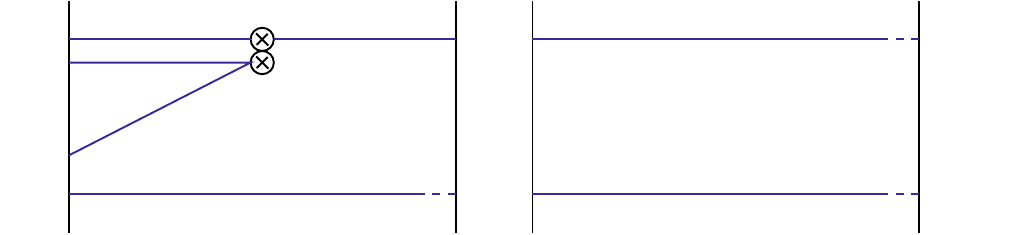
the four-quark operator insertion, and dashed lines indicate the explicit time-like link variable involved in boundary-to-boundary quark propa-